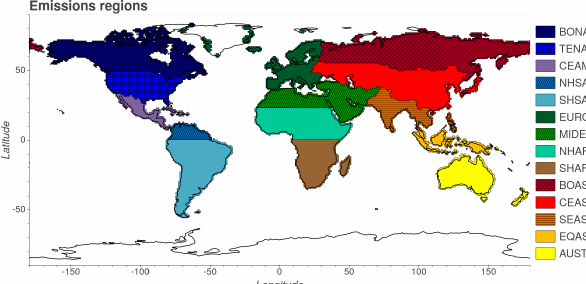
Figure 12. Emissions regions used for the SOFT-IO v1.0